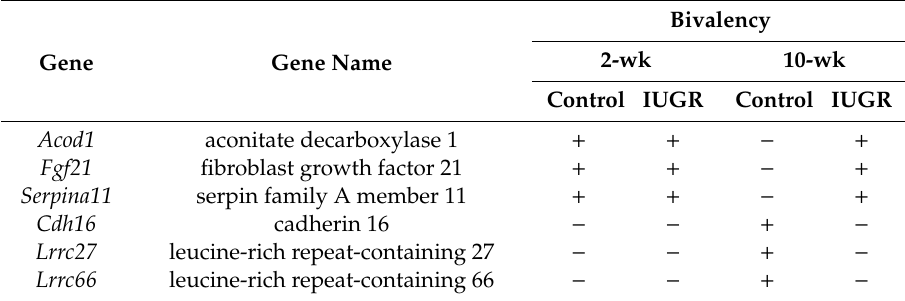
Table 7. Potential bivalent genes critical for long-term IUGR